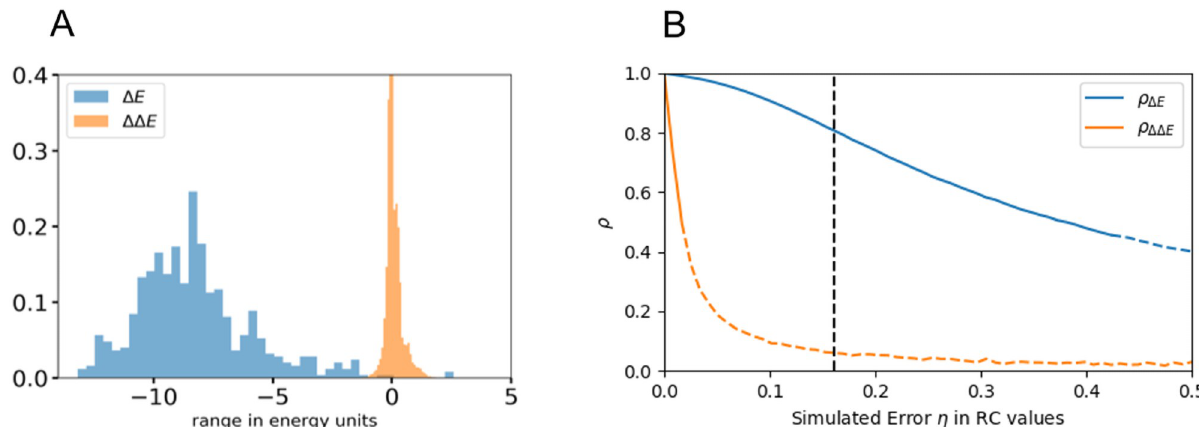
Fig 6. (A) The dynamic range of the measurements (experimental) or predictions (model) of the epistatic effects through the use of double mutant cycles is an order of magnitude smaller than the range of measurements/predictions of the fitness/likelihoods of point mutations. This makes predictions for double mutant cycles more susceptible to noise. (B) Simulation of the expected correlation of the Potts model prediction to experimental values for Δ E and ΔΔ E as a function of simulated experimental noise η , showing that the the correlation for ΔΔ E drops much more quickly. The dotted section of the curves show where the p -value for the ΔΔ E correlation is > 0.05, or insignificant, showing that noise can make it impossible to verify ΔΔ E values even when Δ E values are well predicted. The level of noise corresponding to Δ E correlation of ρ � 0.8, as in Fig 4 column 6 for Capsid, is shown in dashed